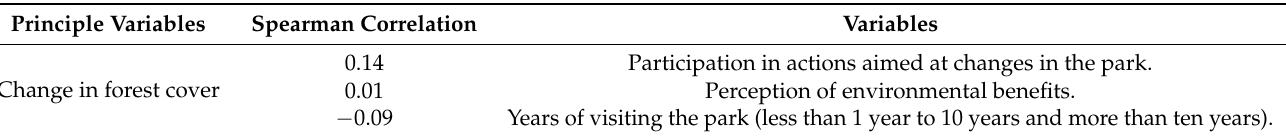
Table 2. Change in forest cover of Mirador Sur Park with respect to influencing